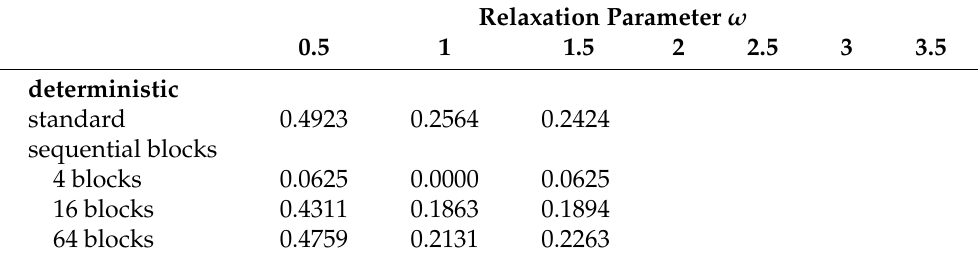
Table 2. Convergence factors for various algorithms, for a random overdetermined consistent equation of size 1023 × 255. Numbers in parentheses represent the estimates from Equation